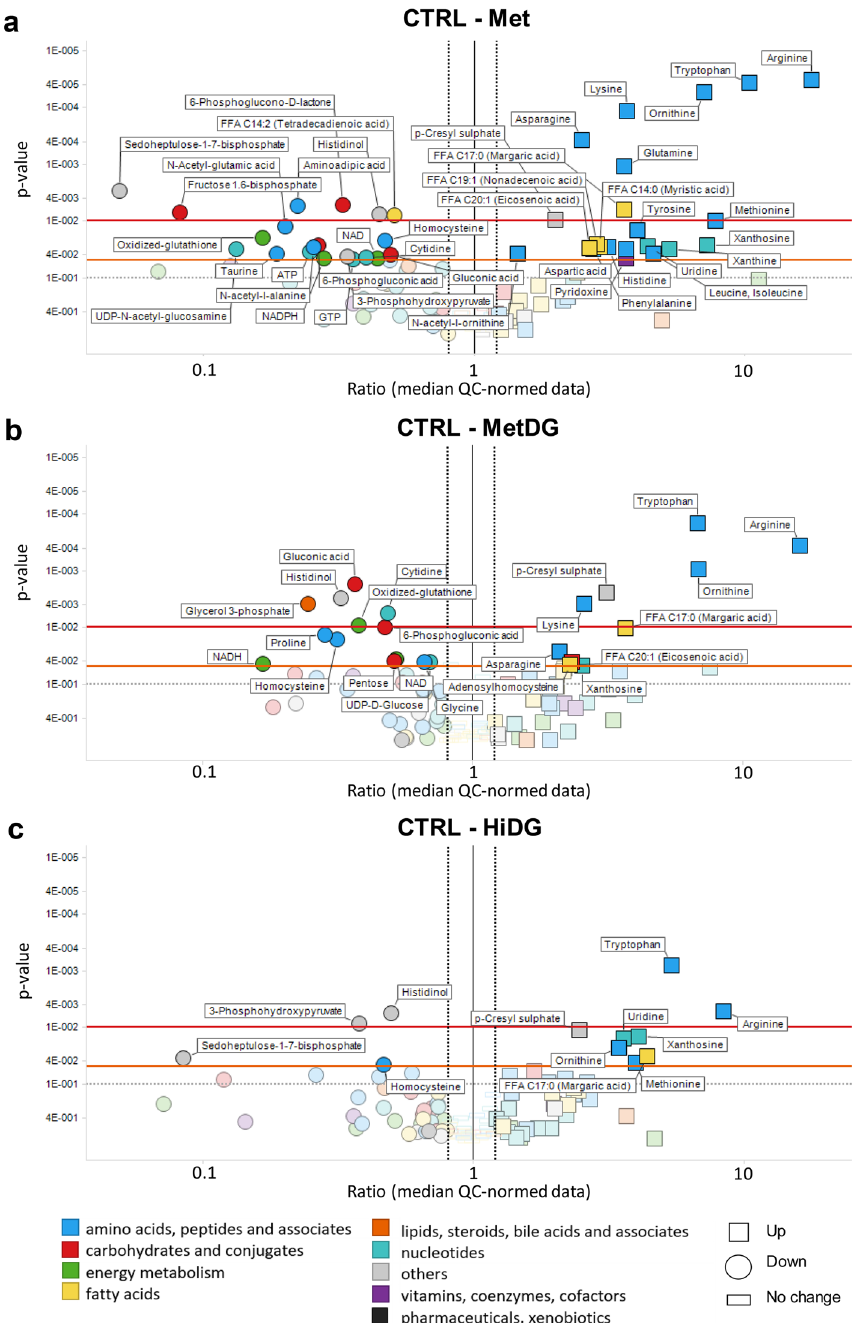
Figure 3. Volcano plots of metabolite levels in the attached cells for Met ( a ), MetDG ( b ) and HiDG ( c ) compared to control. Metabolites on the left side of the black line were decrease while those on the right side of the black line were increased in Met ( a ), MetDG ( b ) or HiDG ( c ) compared to CTRL. Y-axis: p values (inverse log scale); x-axis: metabolite ratios (median QC normalized data, log-scaled). Left black dotted line (0.8)—ratio of 0.8; right black dotted line (1.2)—ratio of 1.2. The red line denotes a p value of 0.01, the orange line denotes a p value of 0.05 and the grey line denotes a p value of 0.1. Metabolites are colored according to the HMDB classes. Metabolites with p value bellow 0.05 and metabolite ratio > 1 or < 0.8 are named. Metabolites are marked with circle for decrease and square for increase in Met ( a ), MetDG ( b ) or HiDG ( c ) compared to